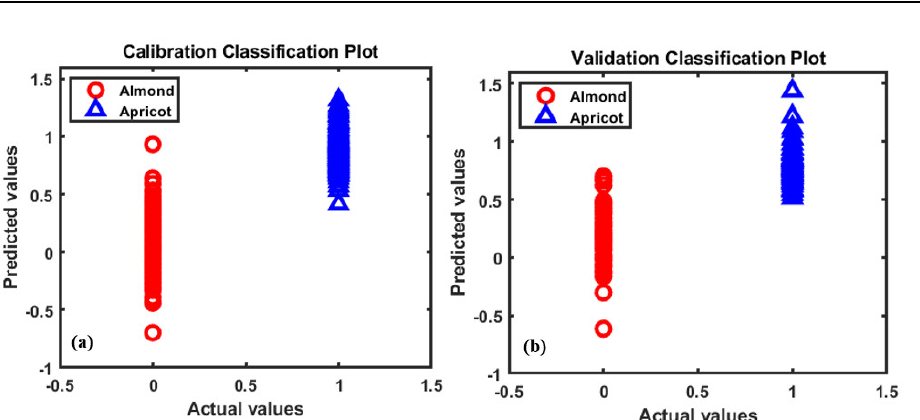
Figure 7. The resultant images of the PLS-DA model from raw data in the first and second variety with 50% detection (red indicates apricot seeds and green indicates almonds), presenting a total image-based classification accuracy of 98%.